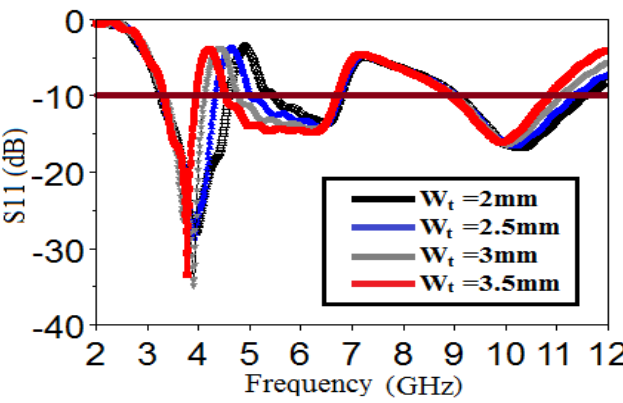
Figure 4: Simulated reflection coefficient for different